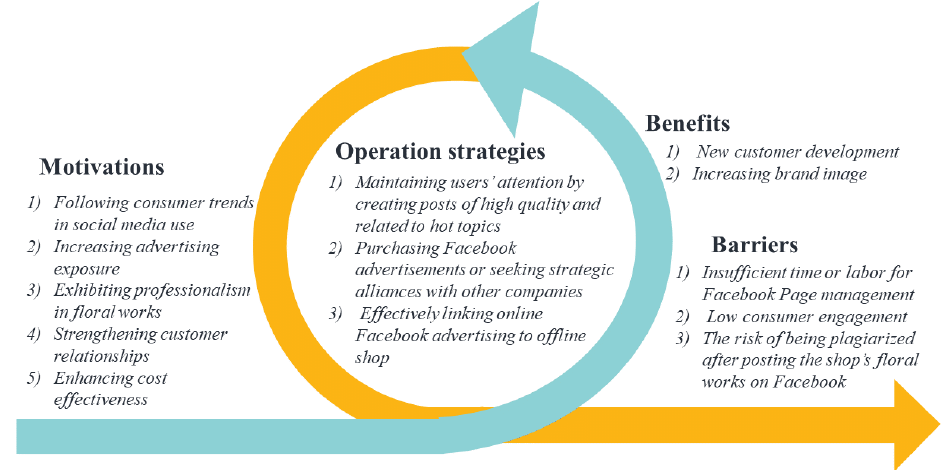
Figure 1. The study findings regarding the florists’ motivations, management strategies, barriers, and perceived benefits for the adoption of social media marketing in flower retailing businesses.